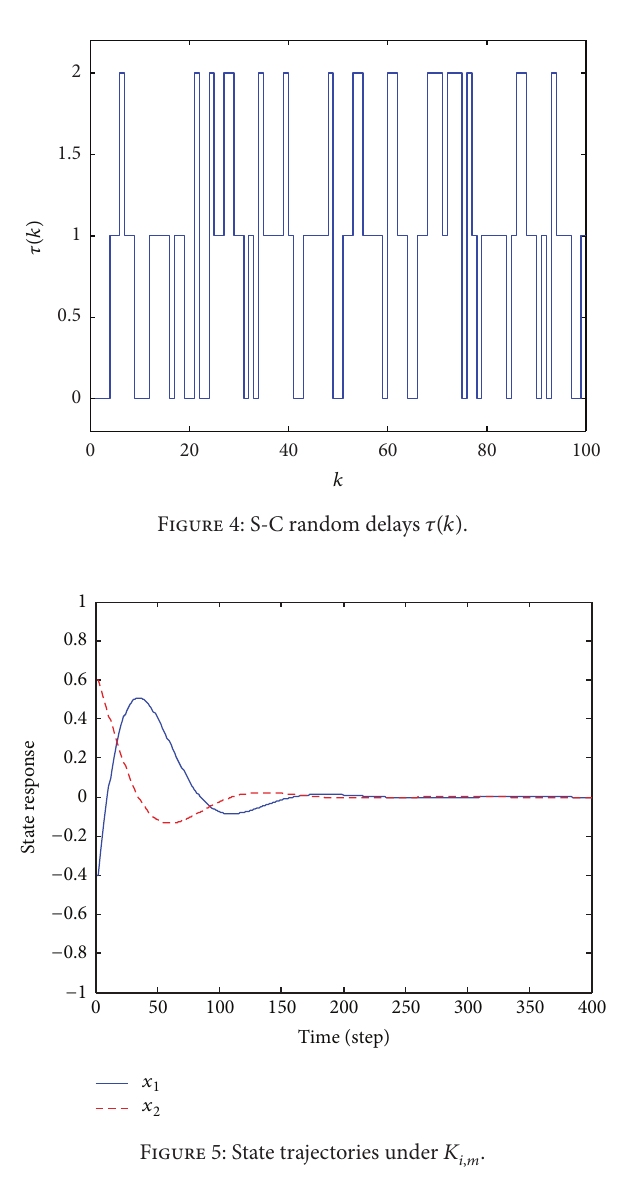
Figure 5: State trajectories under 𝐾 𝑖,𝑚 .